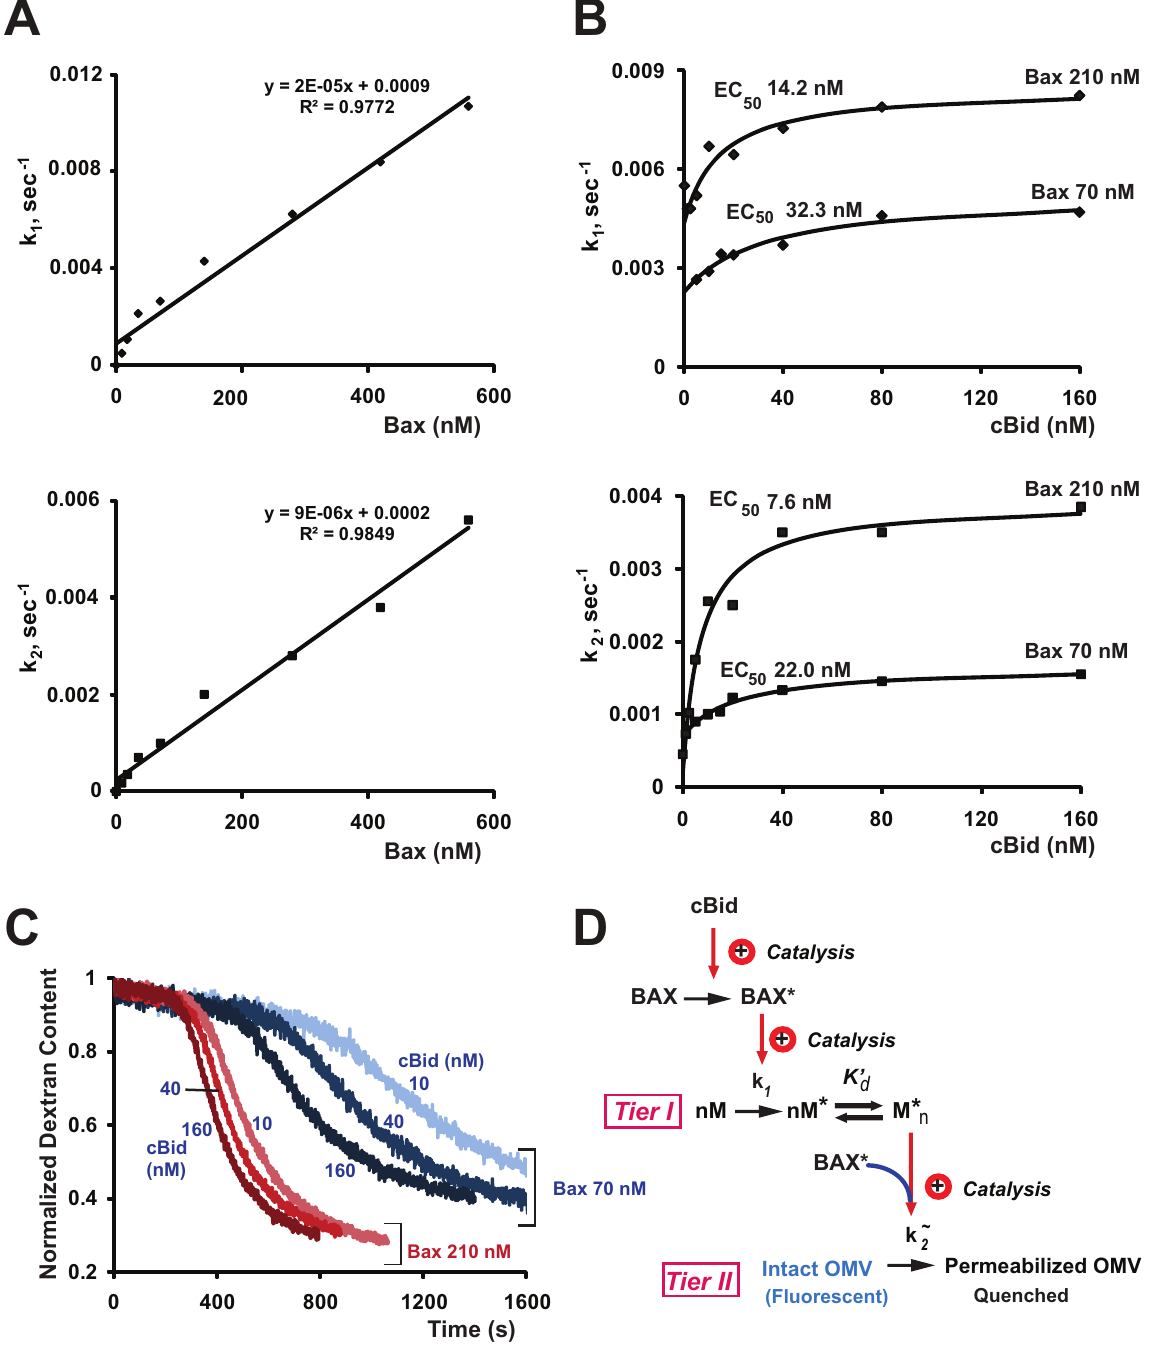
Figure 5. The kinetic parameters showed saturation with respect to cBid, but not Bax concentrations, and exhibited an inverse relationship between [cBid] and [Bax]. (A) Dependence of the rate constants on Bax concentration was linear. Some small deviations from linearity at low Bax concentrations probably reflect systematic error due to the need for long incubations under those conditions. (B) Dependence of the rate constants on cBid concentration was saturable and displayed an inverse relationship with the amount of Bax (lower EC 50 values at higher Bax concentration). The assay was performed as in Figure 2A,C. Data shown in (A) and (B) are representative of three independent experiments. Kinetic parameters were determined using equation 9; cBid dose-response data (B) were fit to hyperbolic curves (solid lines) using GraphPad Prizm